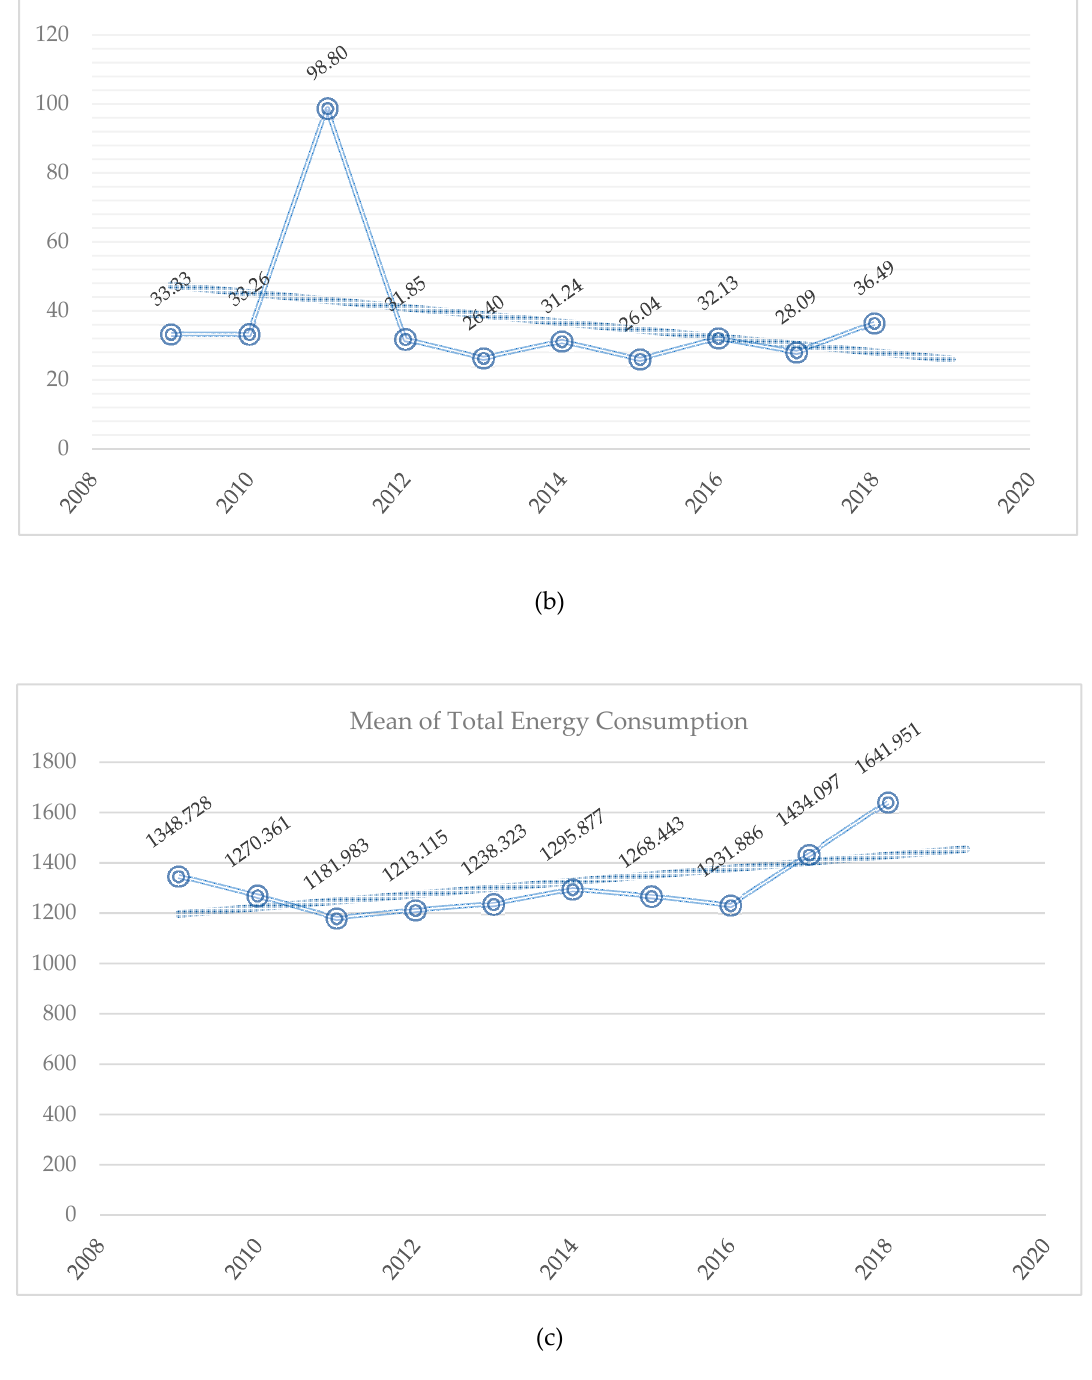
Figure 1. The annual means of (a) total water use, (b) total waste, and (c) total energy consumption. Source: Authors’ work.